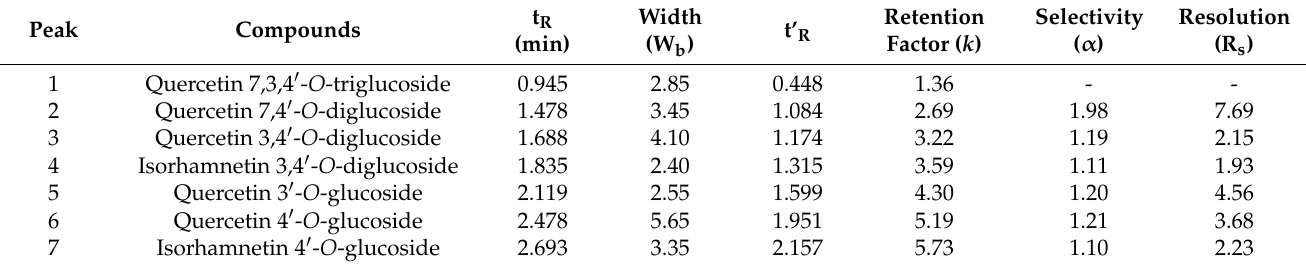
Table 2. Chromatographic properties of the developed ultra-high performance liquid chromatography (UHPLC) method for flavonols in